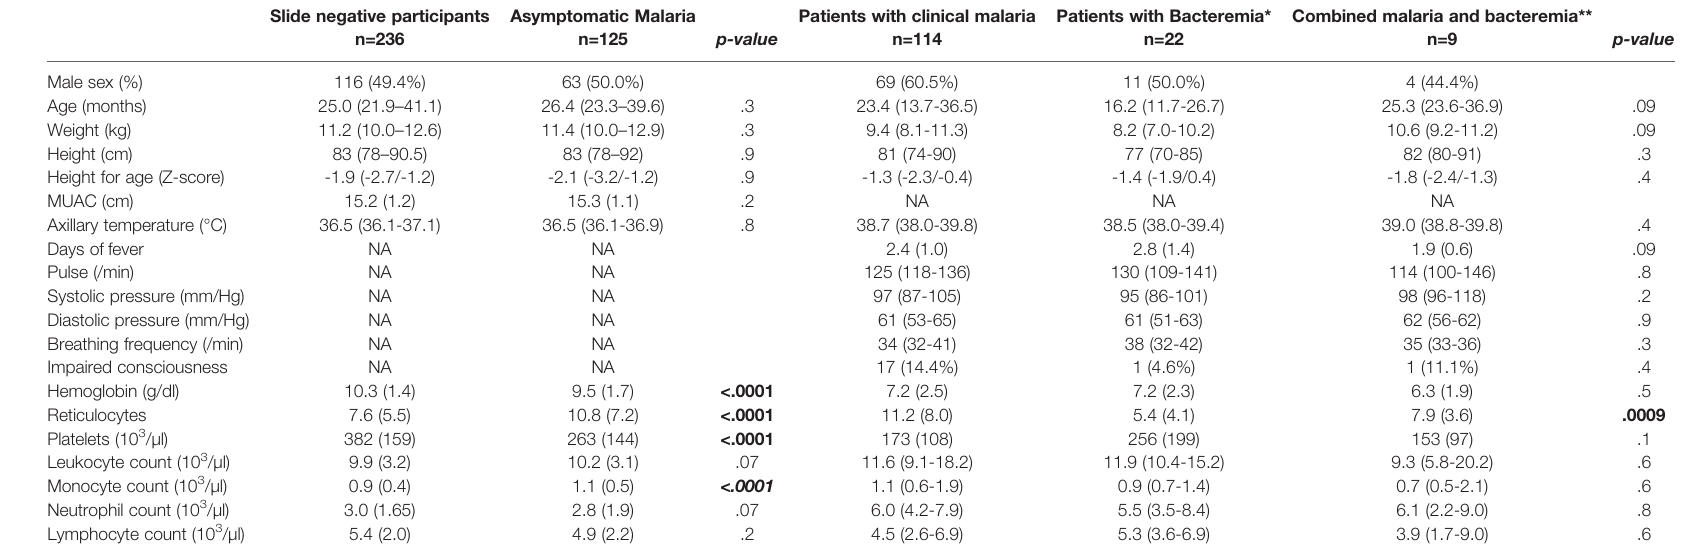
Dataispresentedasmean(SD)incaseofnormallydistributeddataandmedian(25-75IQR)incaseofnotnormallydistributeddata.Signi fi cancevaluecalculatedusingchi-2forbinaryvalues,Mann-WhitneyU-testincaseofnotnormallydistributed and student ’ s t-test in case of normally distributed values. A Kruskal-Wallis test was done for continuous dependent variables in the diagnostic accuracy study. Parameters with a p-value of 0.1 or less were considered potential confounders. The bold values refer to statistically signi fi cant